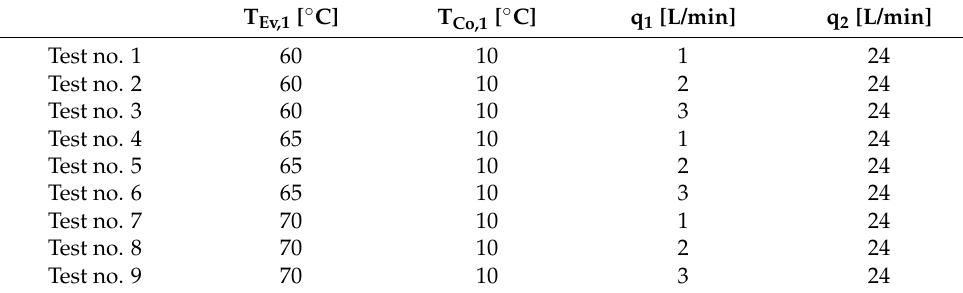
Table 2. Testing